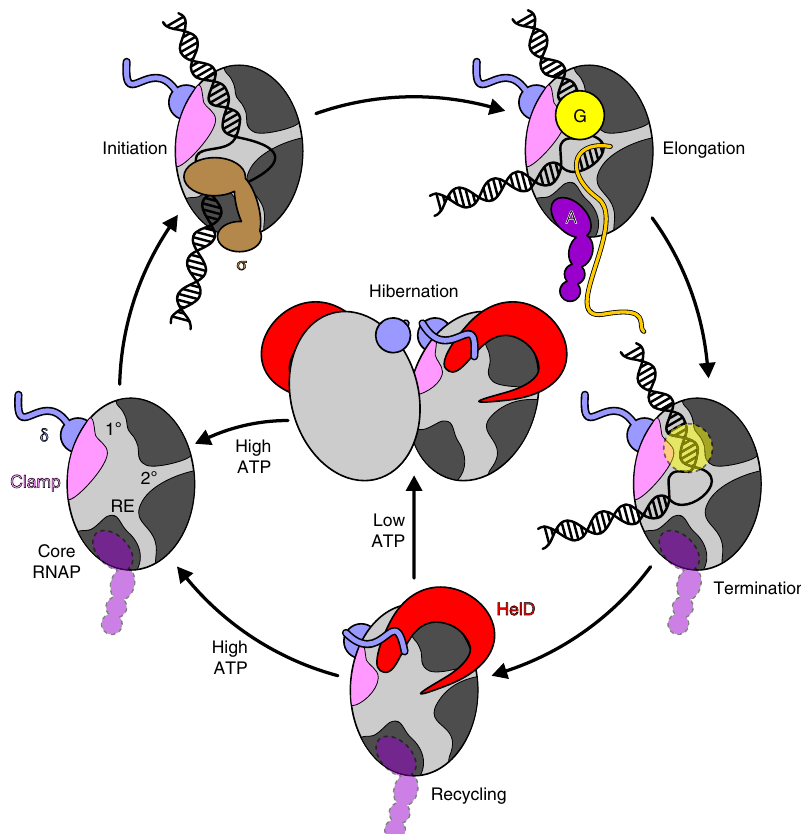
Fig. 7 Model for HelD/ δ -mediated RNAP recycling and putative hibernation. 1°/2°, main/secondary channels; RE, RNA exit tunnel; A/G, general elongation factors NusA/NusG. NusG binds across the active center cleft, while NusA binds to the β FT. Semi-transparent icons with dashed lines indicate that the respective factor may be released at the respective step. If the factors remain after termination, NusG will likely be displaced by HelD-induced main channel opening, while the NusA binding site is sequestered in dimeric (RNAP- δ -HelD) 2 . Hibernation by RNAP- δ -HelD dimerization and ATP- mediated recovery from the dormant state represent tentative aspects of the